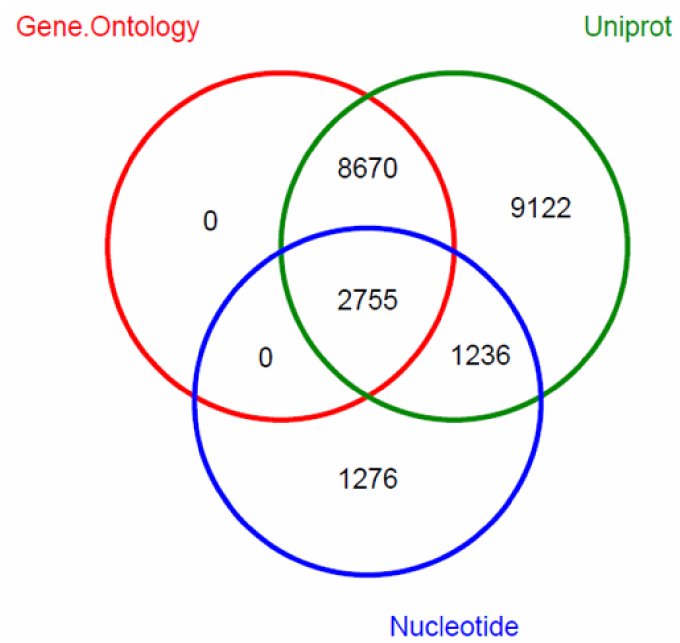
Figure 3. Distribution of annotated unigenes across databases. Venn diagram for common annotated unigenes in NT, UniProt and Gene Ontology